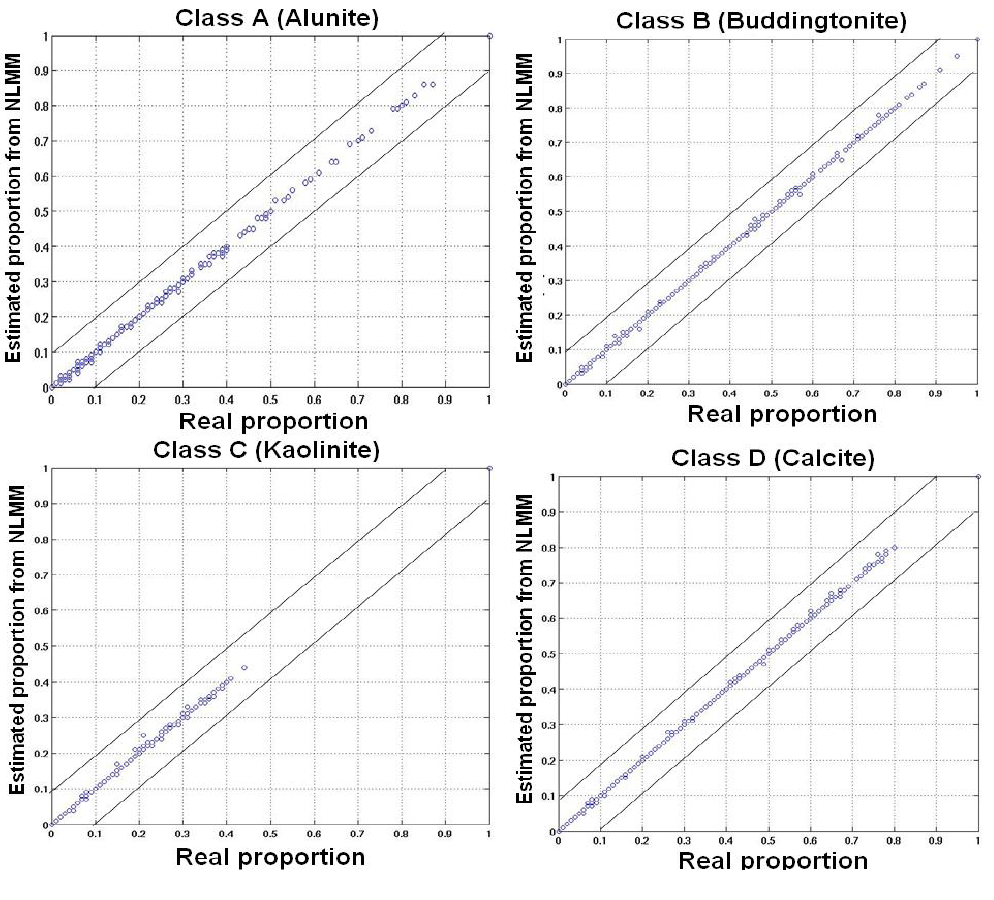
Figure 9. Bivariate Distribution Functions (BDFs) of simulated test data for the four minerals obtained from